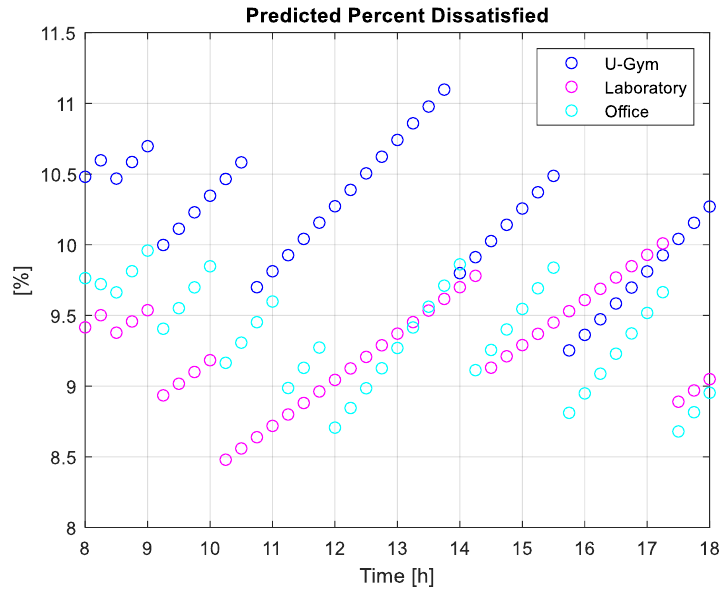
Figure 15. Predicted percent dissatisfied values. Table 2. Discomfort indicator